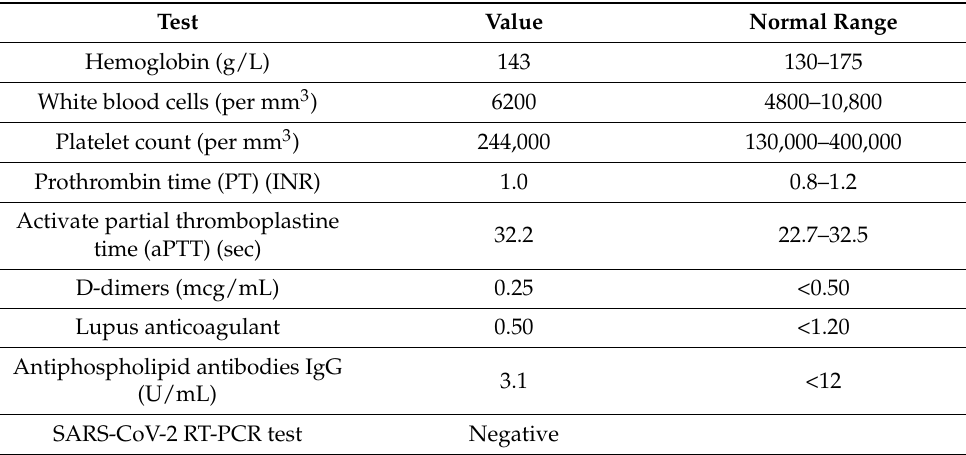
Table 1. Laboratory